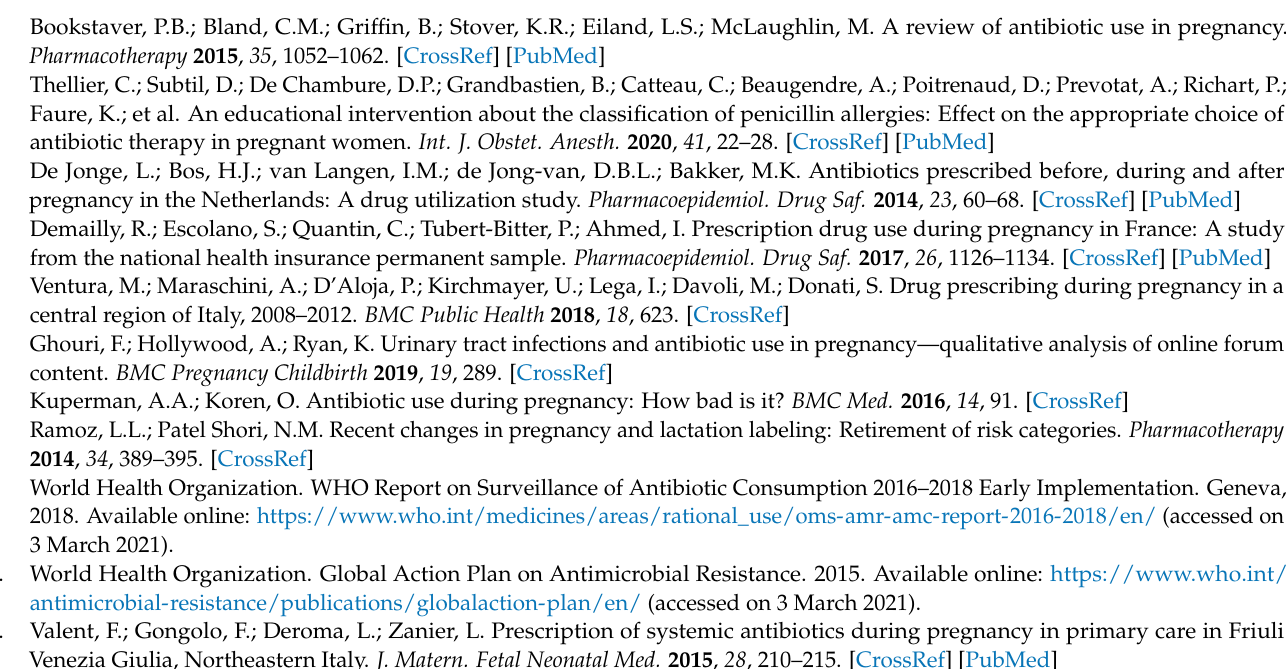
categories. Table S1: Number of included and excluded hospitals in different subgroups. Table S2: Outpatient visits in included and excluded hospitals for various subgroups. Table S3: Antibiotics prescribed for pregnant women and the categories. Table S4: Percentages of Antibiotic prescription s during pregnancy by age group and diagnosis. Table S5: Prescription proportions of all antibio tic agents used by pregnant